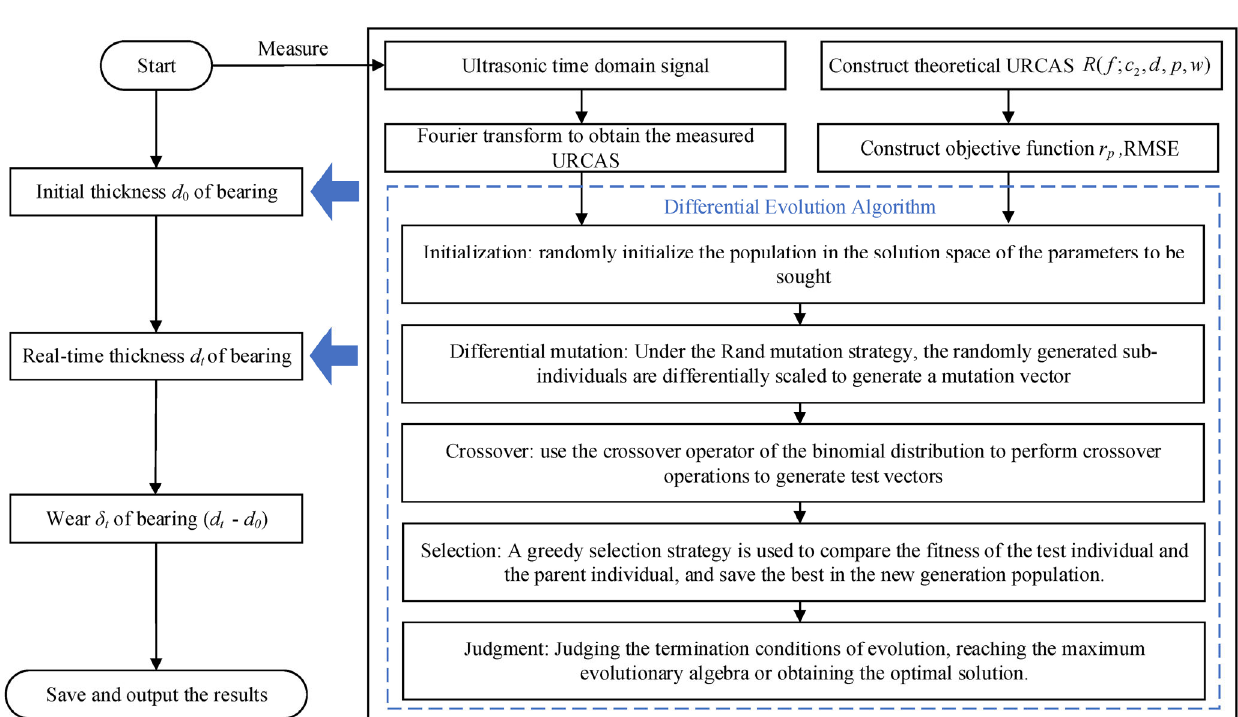
Fig. 3 Flow chart of polymer bearing wear monitoring